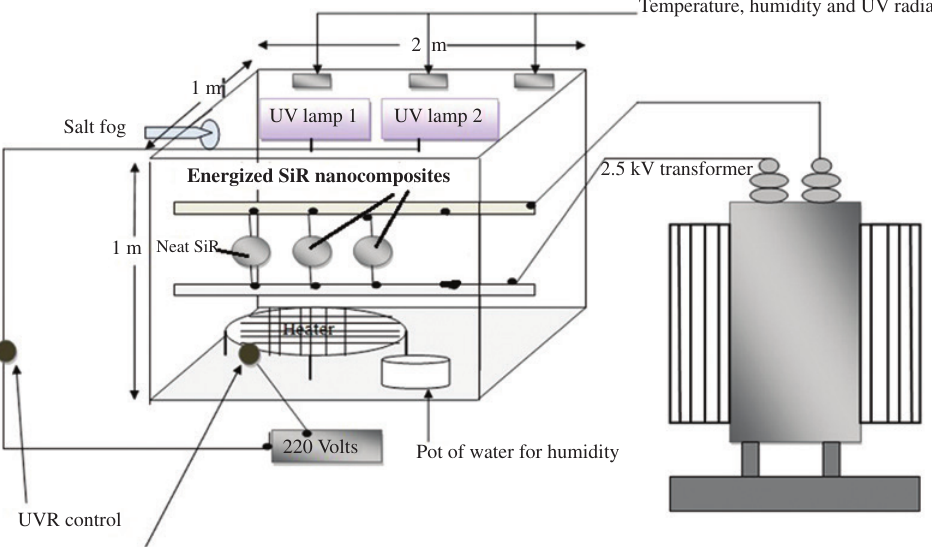
Figure 1: Accelerated multistress environmental